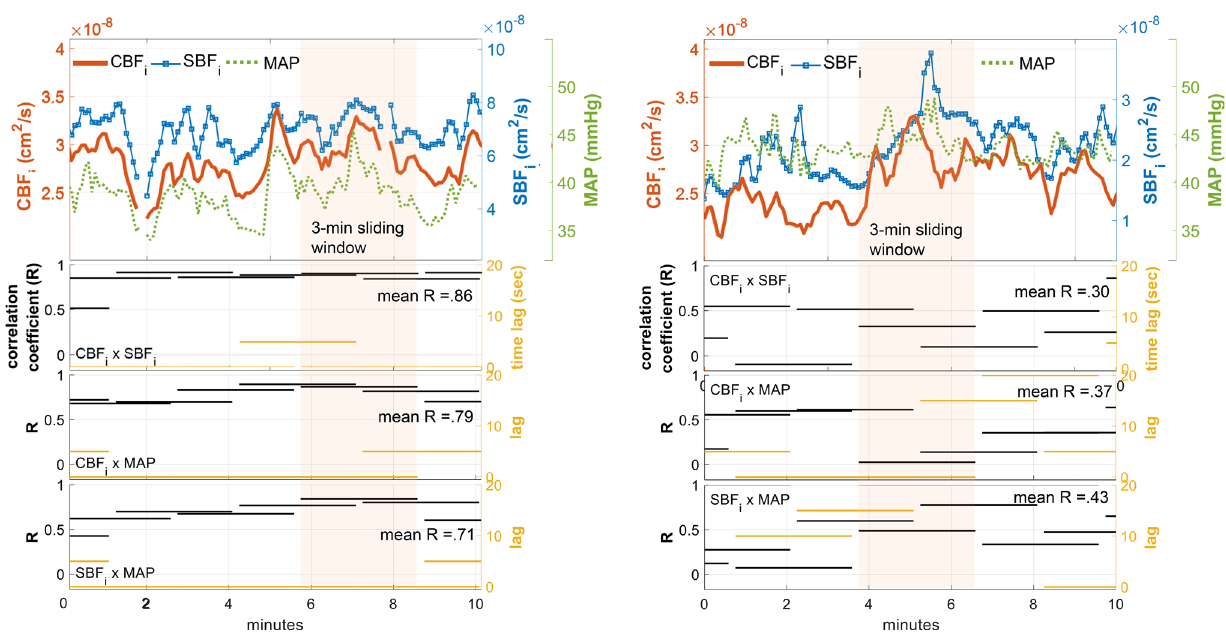
Figure 3. Correlation-based indices of impaired (left) vs healthy (right) cerebral autoregulation showed a possible association with IVH. Left: A 24 week GA ELGA infant with grade IV IVH diagnosed on the same day of the DCS measurement (day 3 of life), showing strong and frequent pressure passive events as the correlation was 0.8–0.9, and the time lags were mostly at 0–5 s between CBF, SBF, and MAP. Right: In an infant with no IVH, CBF (red tracing) was out of phase compared to SBF (blue tracing with square markers) within the 3-min window, as well as in MAP (dotted green tracing) vs CBF (red tracing). On average, the correlation was lower (< 0.5) and with a longer lag (0–20 s) than in the IVH example. For both left and right: Visually, SBF (blue tracing with square markers) showed the signal peaks that were correlated with MAP (dotted green tracing); A 3-min, 50% overlapping sliding window was used to compute the best positive correlation between leading and following signals up to 20 s of time lag; Shown here is a segment of 10 min of